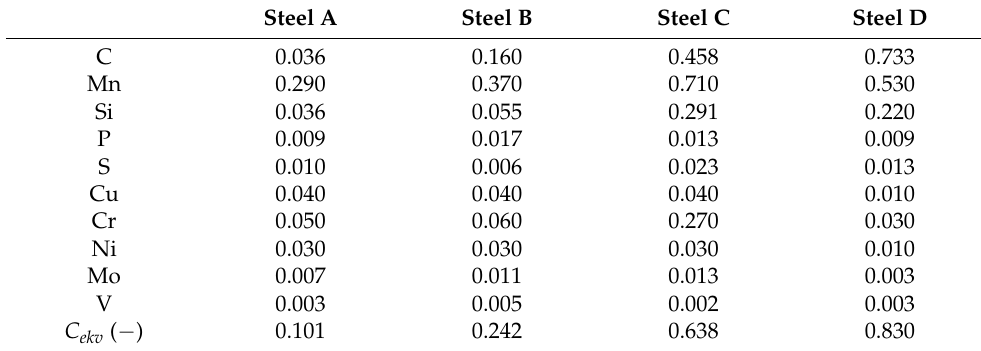
Table 1. Chemical composition of investigated steels in wt %. Steel A Steel B Steel